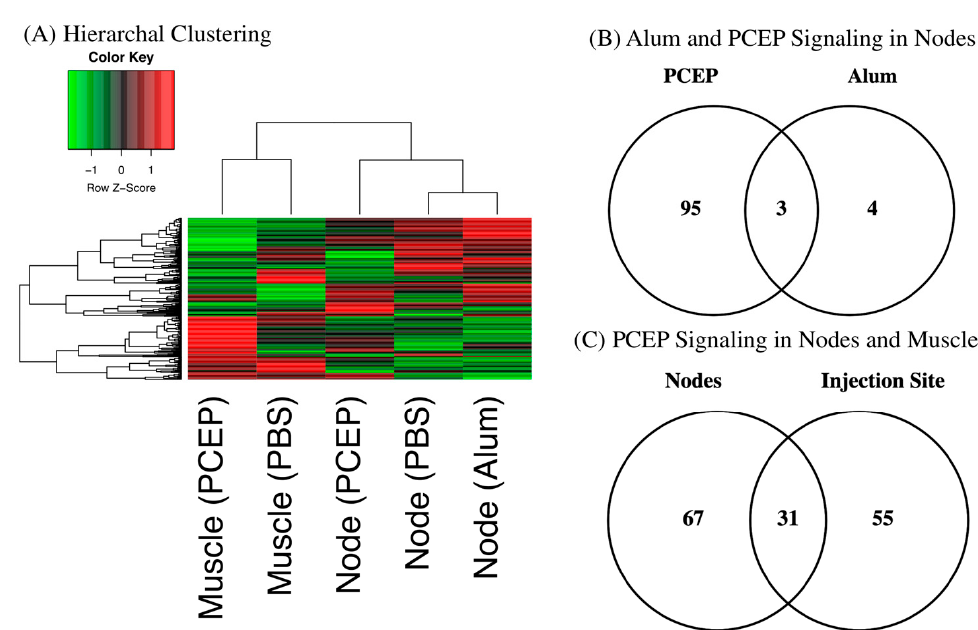
Figure 1. Kinome Responses to PCEP and Alum at Site of Injection and Lymph Node. ( A ) Clustering of Kinome Responses at Site of Injection and in Draining Lymph Nodes. Hierarchical clustering of kinome datasets. (1 − Pearson correlation) was used as the distance metric, while McQuitty linkage was used as the linkage method. Colors indicate the average (over nine intra-array replicates) normalized phosphorylation intensity of each target, with red indicating greater amounts of phosphorylation and green indicating lesser amounts of phosphorylation. ( B ) Venn Diagram of Differentially Phosphorylated Peptides in Lymph Nodes to PCEP and Alum. Comparison of peptides consistently and significantly ( p < 0.05) phosphorylated in lymph in response to either PCEP or Alum relative to PBS control. ( C ) Venn Diagram of Differentially Phosphorylated Peptides in Lymph Nodes and Muscle to PCEP. Comparison of peptides consistently and significantly ( p < 0.05) phosphorylated in lymph and muscle in response to PCEP relative to PBS